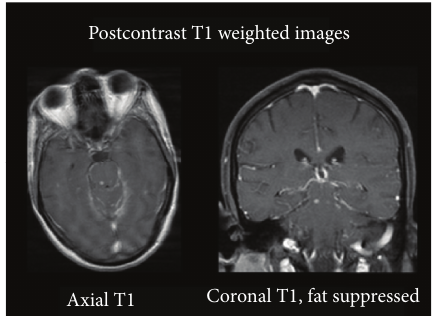
Figure 3: Postcontrast T1 weighted images. Enhancement of the same T2 hyperintense lesion can be seen. The axial image shows enhancement of the basilar meninges which is also commonly seen in TB.